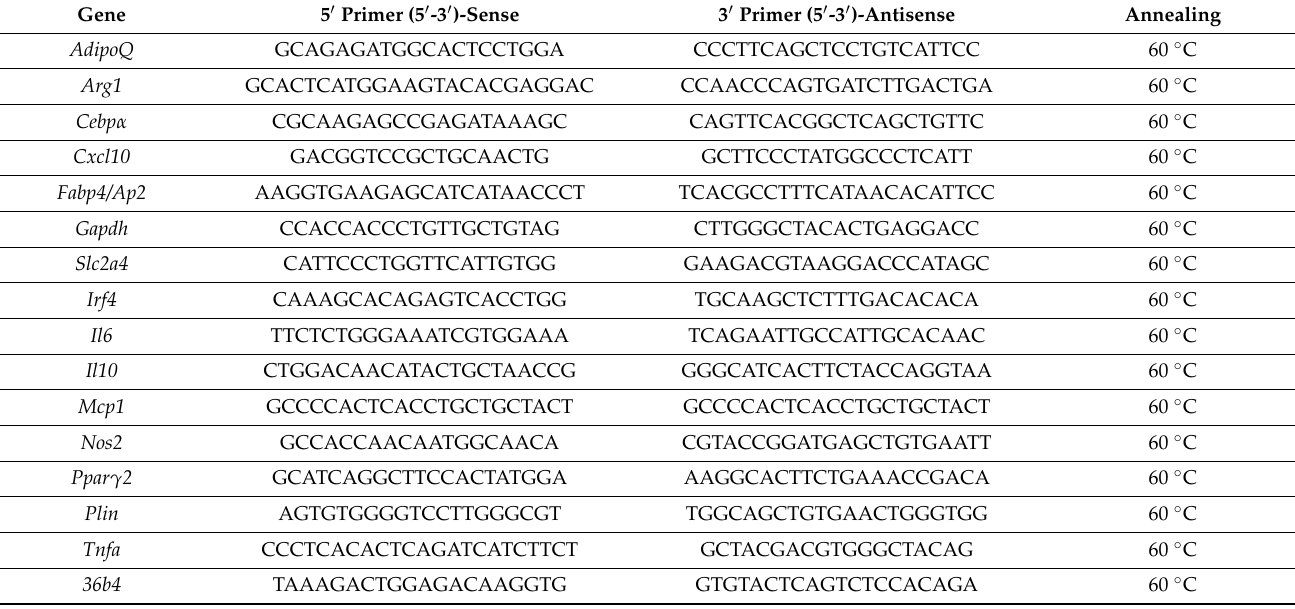
Table 1. Sense and antisense sequences of primers used in real-time